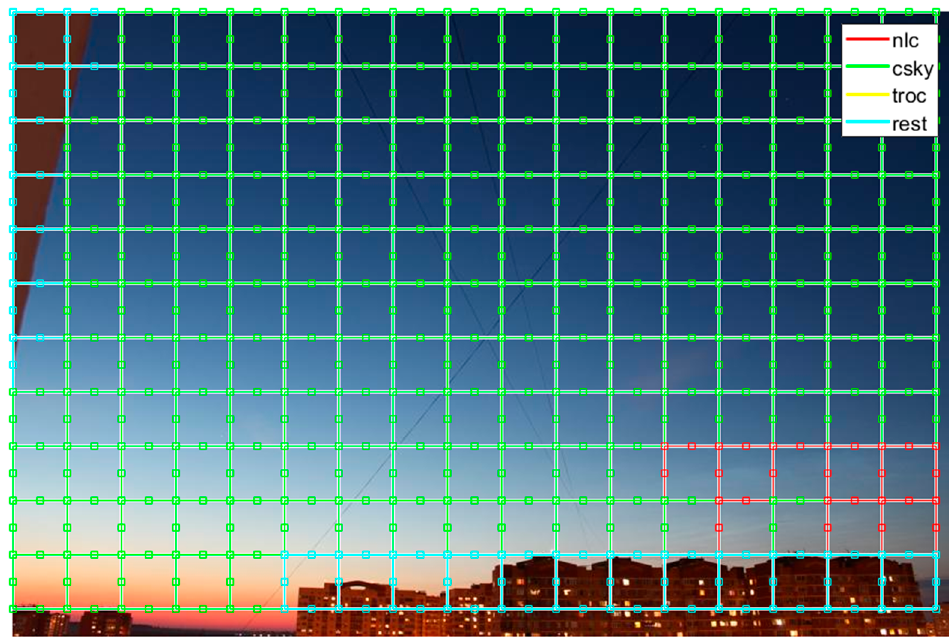
Figure 12. The majority of the noctilucent cloud activity is correctly predicted by the CNN algorithm.